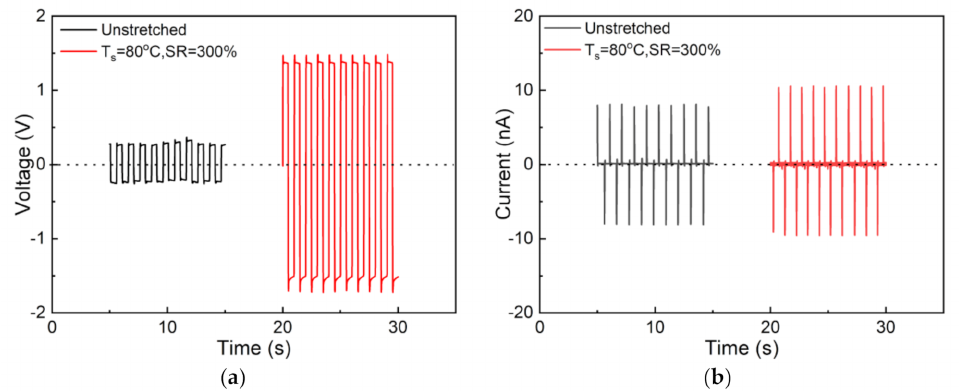
Figure 10. ( a ) Open-circuit voltage and ( b ) short-circuit current for the nylon-11 piezoelectric devices made of the unstretched and 300% stretched films (T s = 80 ◦ C) under a load of 50 N at 1